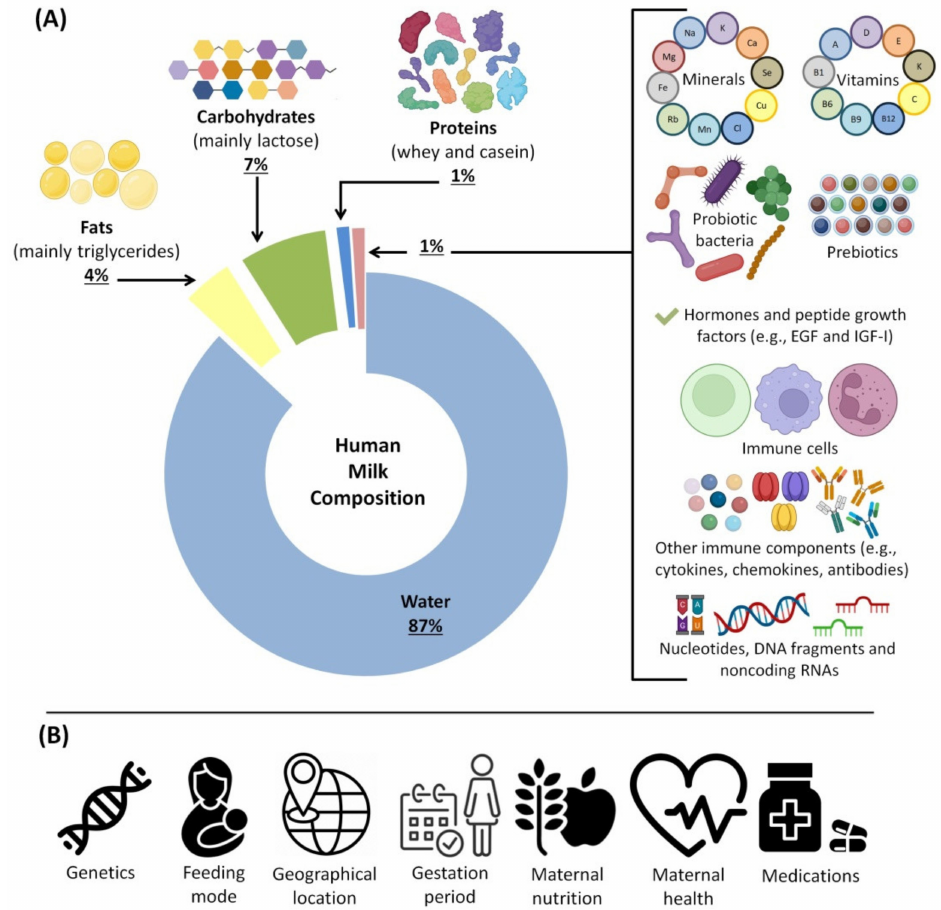
Figure 2. Schematic presentation of HBM components ( A ) and factors affecting its production and composition ( B ). Generally, HBM has four main components, water, carbohydrates, fats and protein. In addition, HBM contains a variety of nutrients, vitamins, minerals, prebiotics, probiotics, hormones, immune cells and substances, nucleotides and nucleic acids and other rare elements. This unique mixture of beneficial components varies due to many factors, mainly related to the mother’s body and health conditions, as well as gestation period [82–86]. Created with BioRender.com, accessed on 22 April